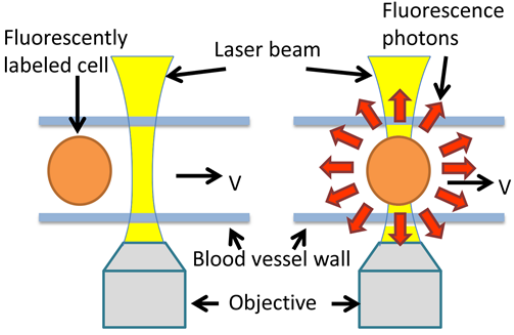
Fig. 1. The basic principle of the in vivo °uorescent °ow